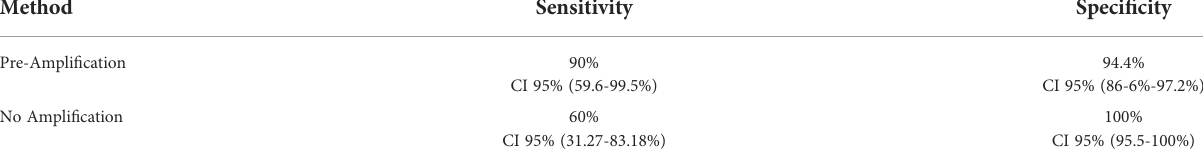
TABLE 2 Sensitivity and speci fi city calculated from the above ROC curve using the endpoint known recurrence values as de fi ned by detection via standard methods (imaging/HCG,LDH,AFP) and a FC >1.1